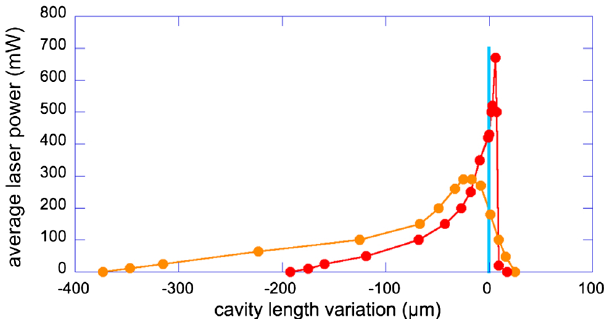
FIG. 1. Variation of laser power of CLIO vs cavity length tuning, at laser wavelength λ ¼ 34 . 6 μ m for 23 MeV electron beam energy. Two curves are displayed for a different tuning of the electron beam. The blue line at the origin is the perfect